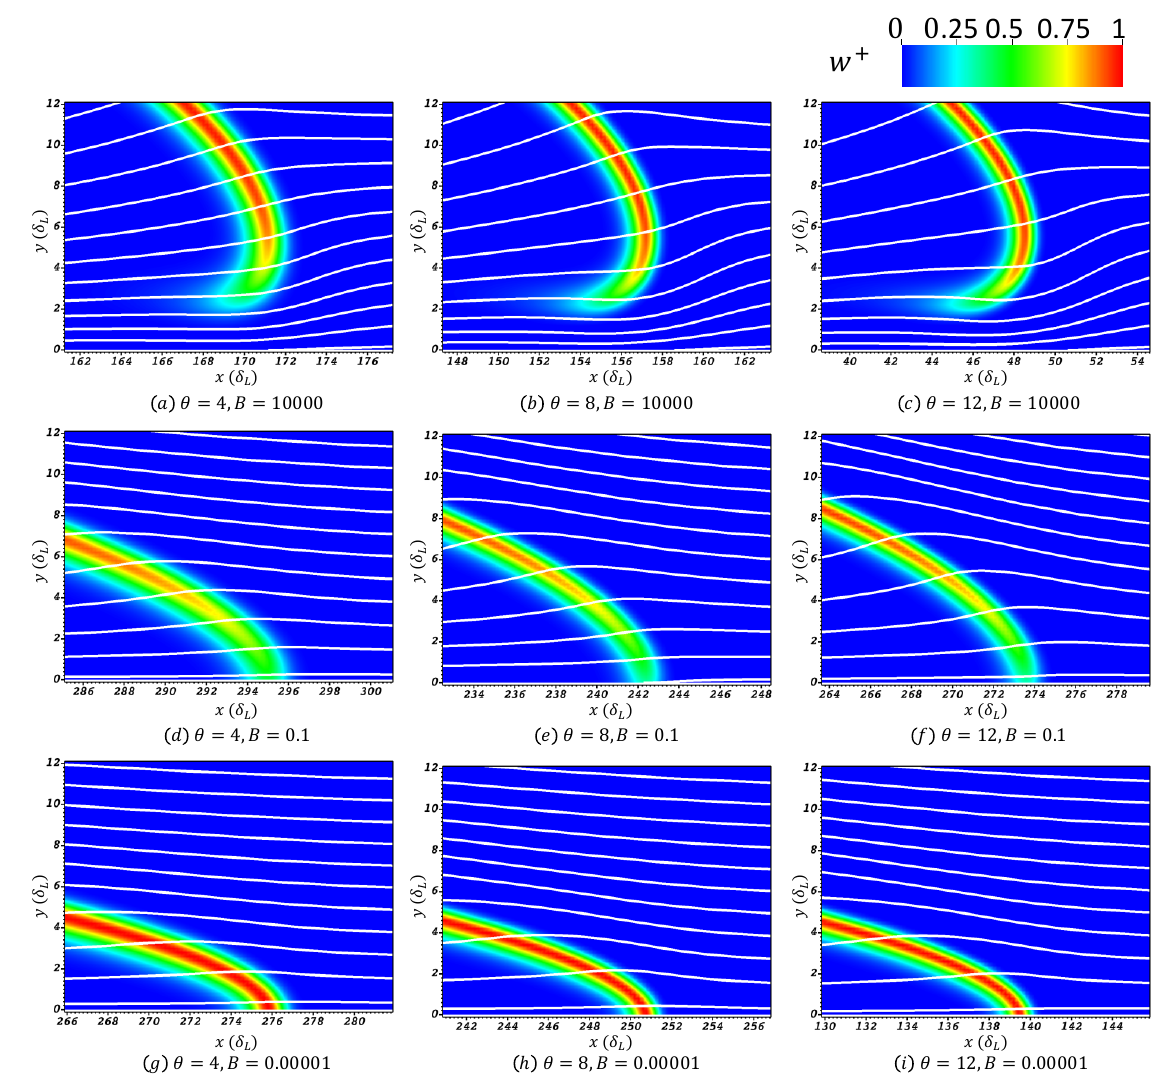
Figure 14. Flame shapes (given by the normalized reaction rate w + and streamlines at the critical condition for θ = 4,8,12 and B = 10 5 , 0.1, 10 − 5 ( R = 60 δ L ).